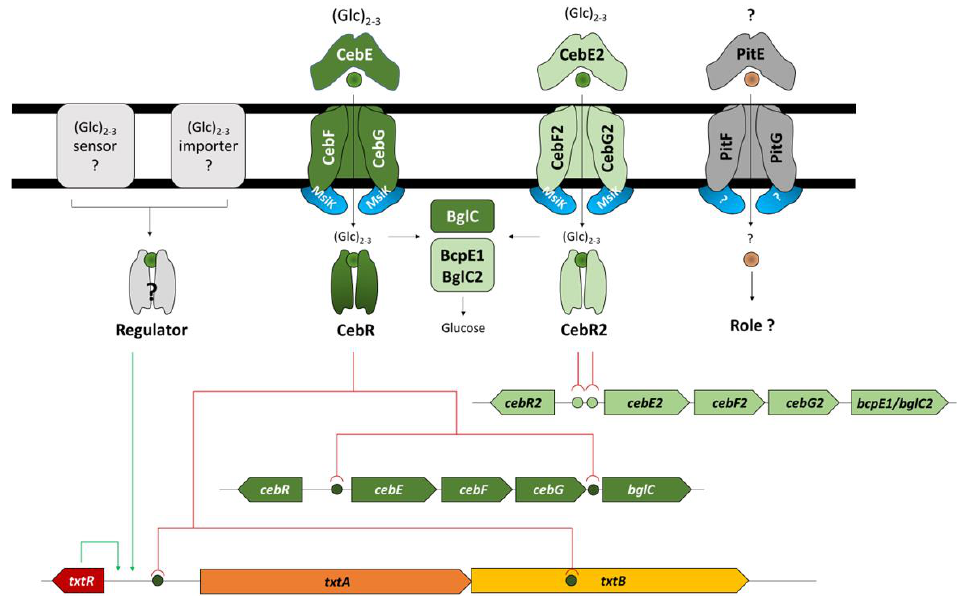
Figure 8. Model of cellobiose and cellotriose transport and thaxtomin production for the onset of pathogenicity in S . scabiei 87-22. Red lines, transcription repression; green lines, transcription activation.